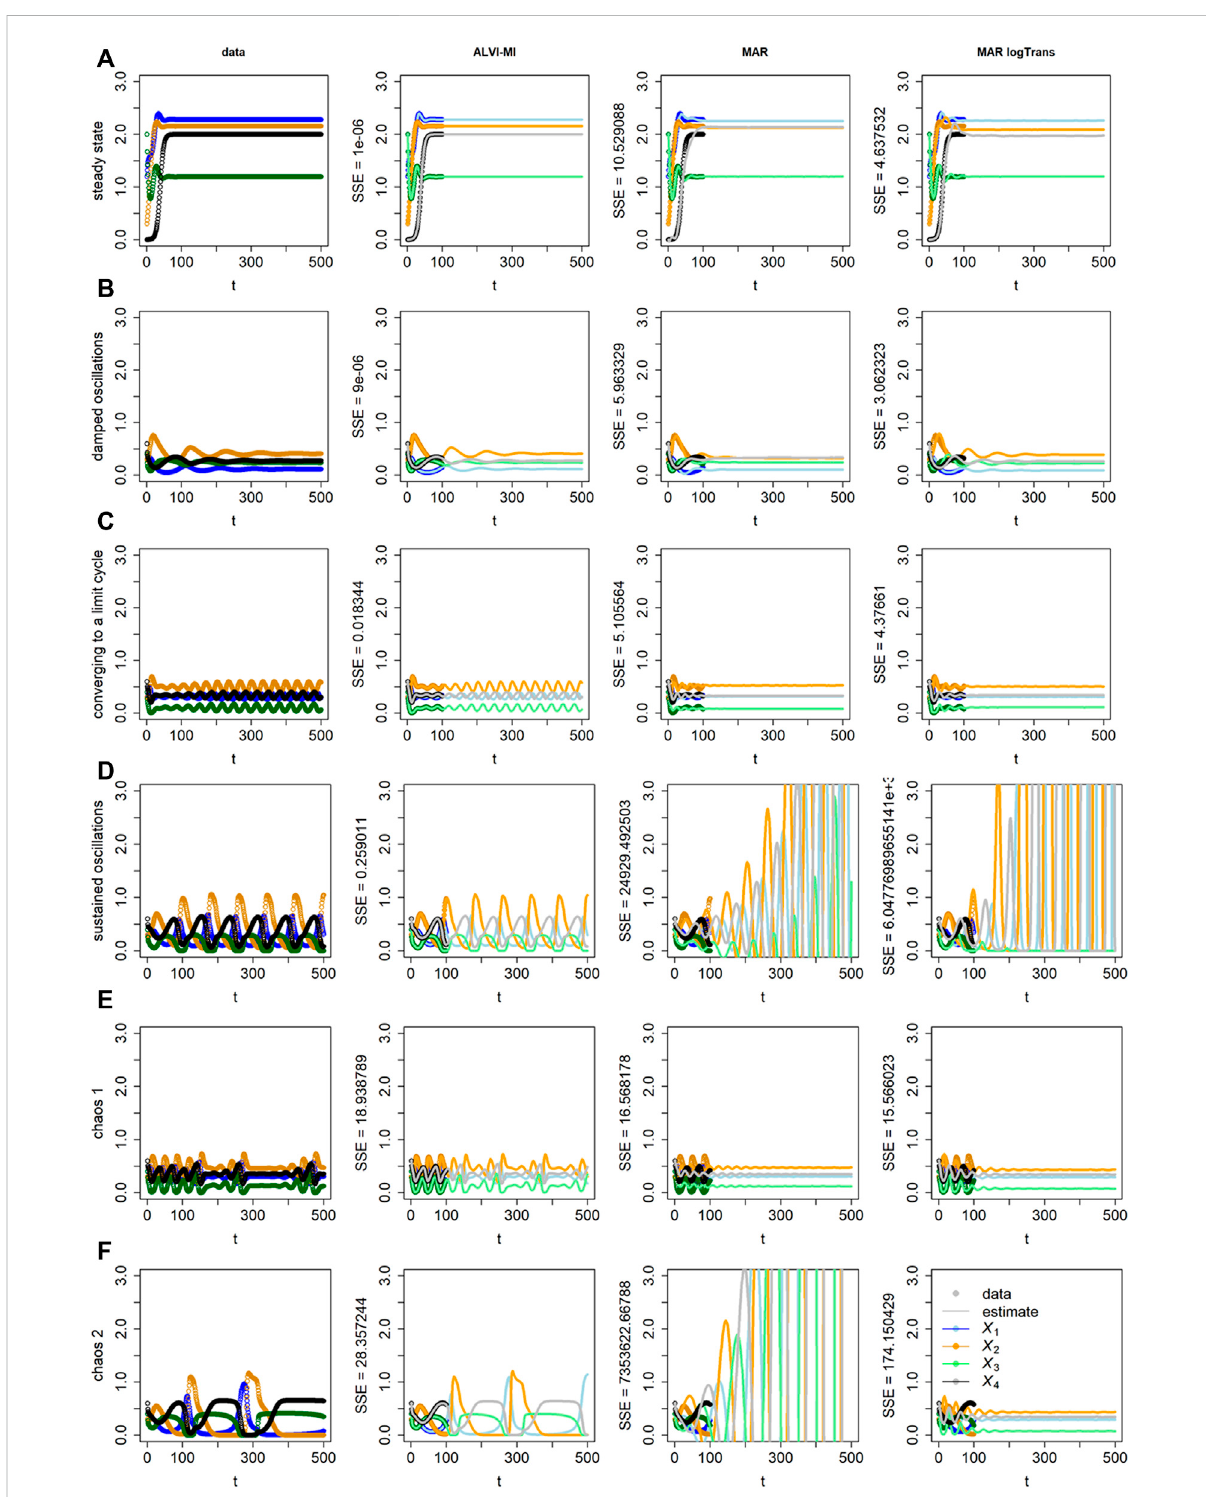
FIGURE 3 “ Data ” (Column 1) and results of inferences with ALVI-MI (Column 2) and MAR methods (Columns 3 and 4) for LV systems exhibiting different types of increasingly complex dynamics. Thick lines in Columns 2 – 4 correspond to the time period from which the data were sampled, while thin lines are extrapolations in time. Row (A) Data converging to a stable steady state; Row (B) Damped oscillations; Row (C) Initially erratic oscillations converging to a limit cycle; Row (D) Sustained oscillations; Row (E) Deterministic chaos, example 1; Row (F) Deterministic chaos, example 2. Data, ALVI-MI and MARSS estimates are presented in Supplementary Table S3. The SSEs concerning the differences between the data and estimates for t ϵ [1, 500] are presented as labels to the Y -axis. No smoothing was needed because the data were noise